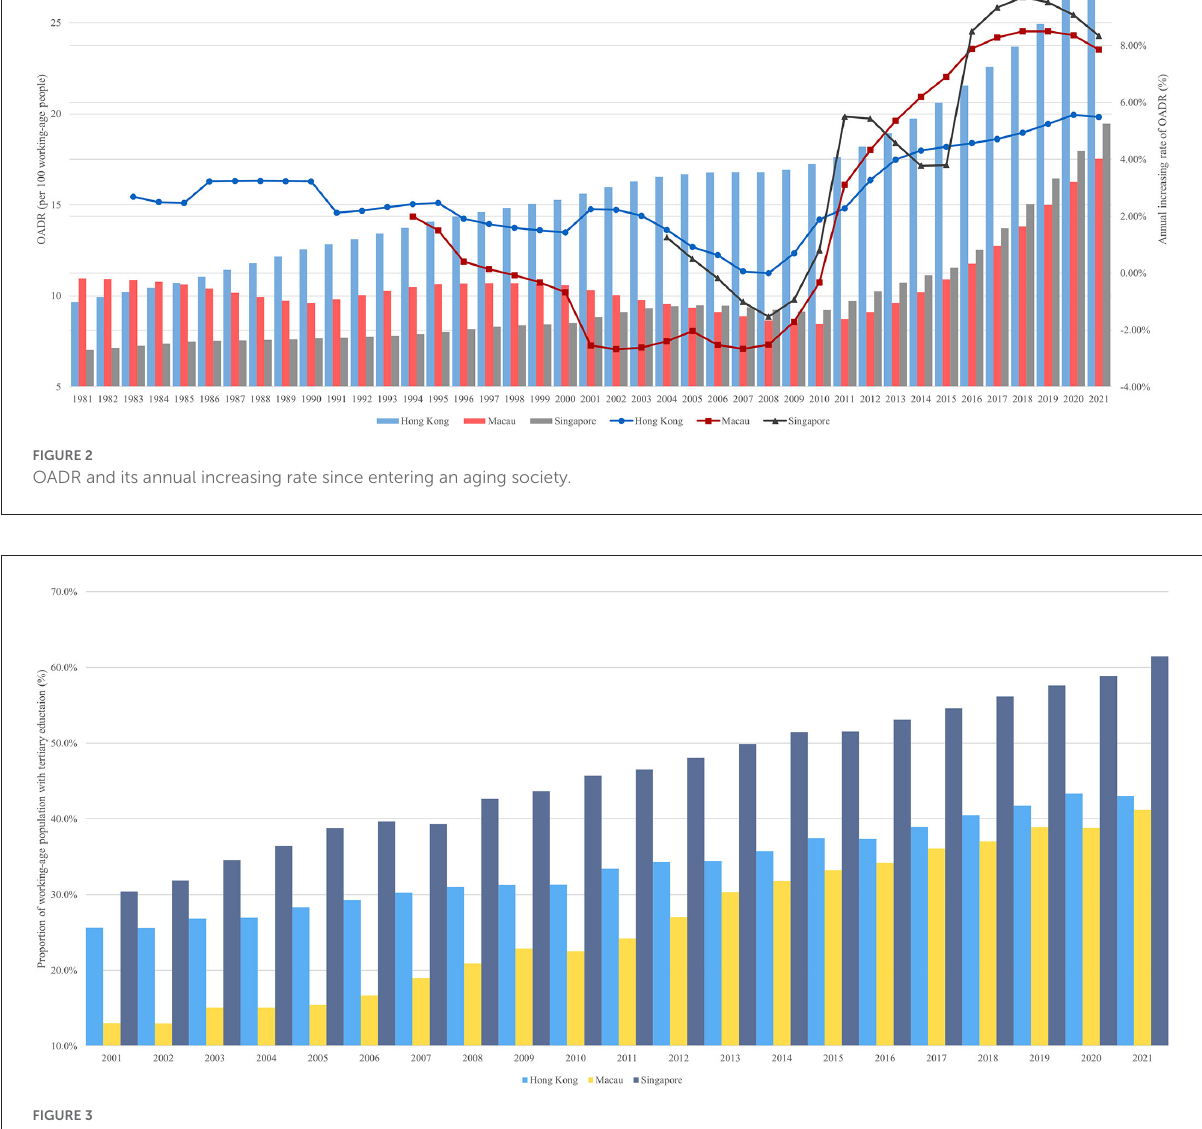
the top in life expectancy at age 65 globally, the figure of Singapore was lower than that of Hong Kong and Macau (Figure 4). In 2021, the life expectancy at age 65 in Hong Kong, Macau, and Singapore was 22.62, 22.56, and 20.23 respectively. Life expectancy at age 65 in Hong Kong and Macau was similar, with the disparity fluctuating within plus or minus 0.5 years. Singapore, on the other hand, had a larger gap with both Hong Kong and Macau, rising to more than 2 years after